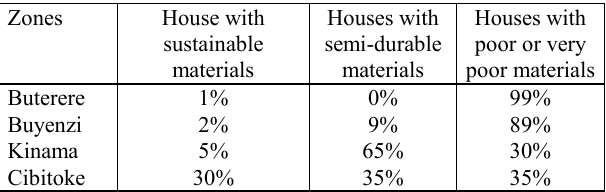
Table 2. The most vulnerable zones due poor quality of